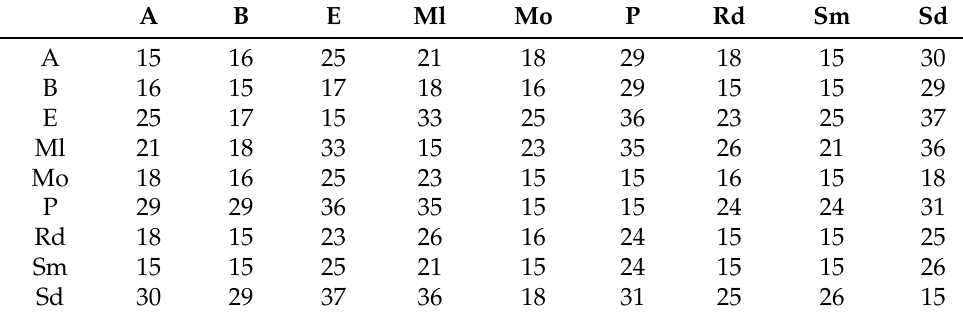
Table 4. The time between locations (in minutes).